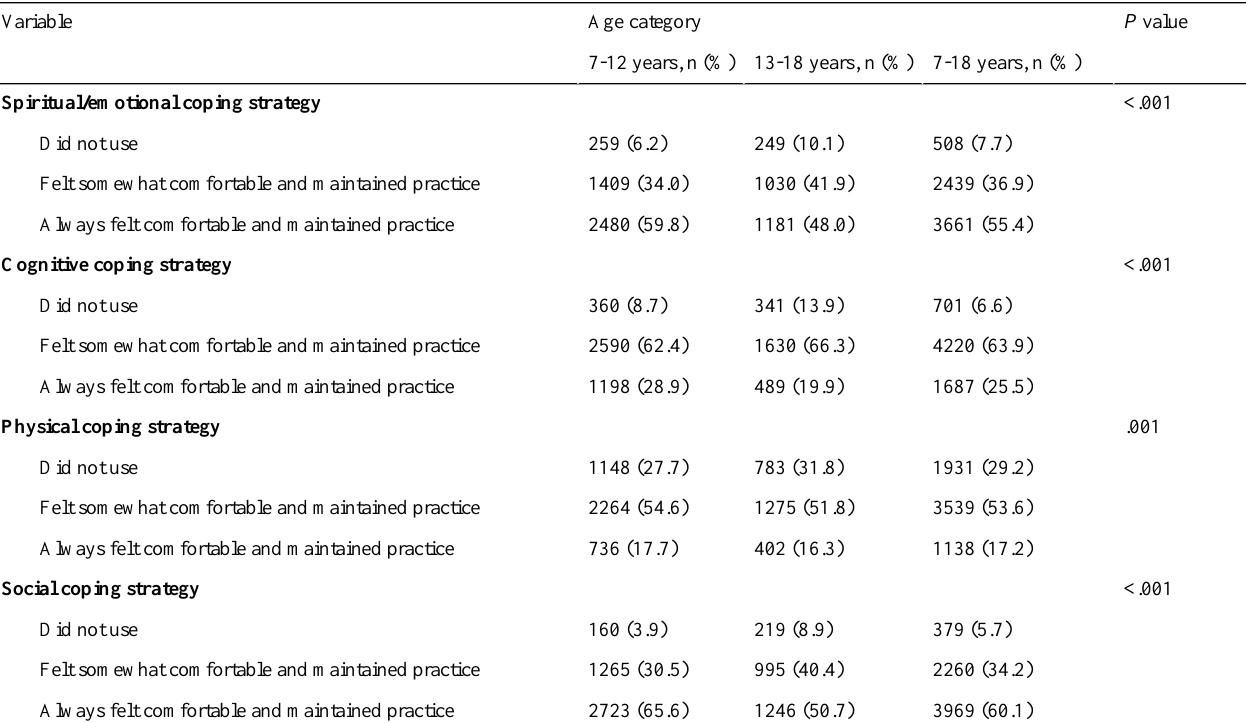
Table 9. Association between age categories in the study population and the coping strategies used